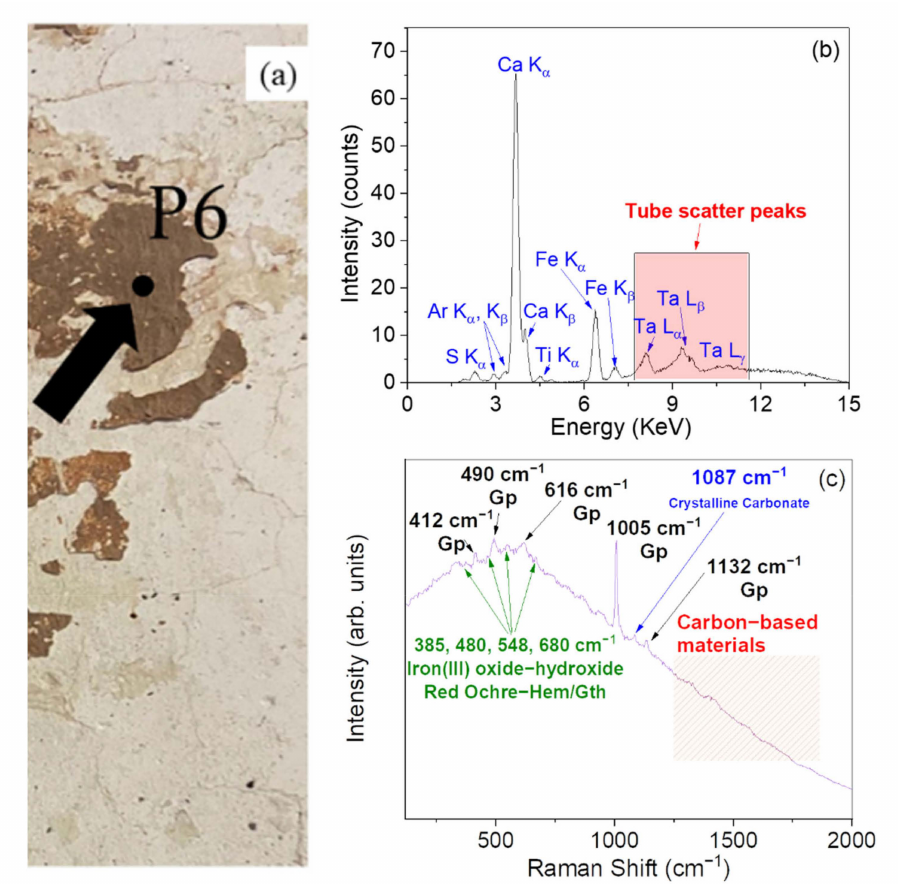
Figure 6. Photo of the point P6 (brown) ( a ). XRF spectrum recorded on the point P6 ( b ). Raman spectrum recorded on the point P6 ( c ). In the figure, Gp: gypsum; Hem: hematite; Gth: goethite. Lazurite’s blue color is attributed to sulfur polyanion radicals trapped in the β -cage structure. Variations in color appear to be related to ratios between various sulfur species: the trisulfur radical (S 3 − ) is mainly responsible for the blue color, but contributions from disulfur (S 2 − ) and tetrasulfur (S 4 − ) radicals can shift the color towards yellow or red, respectively